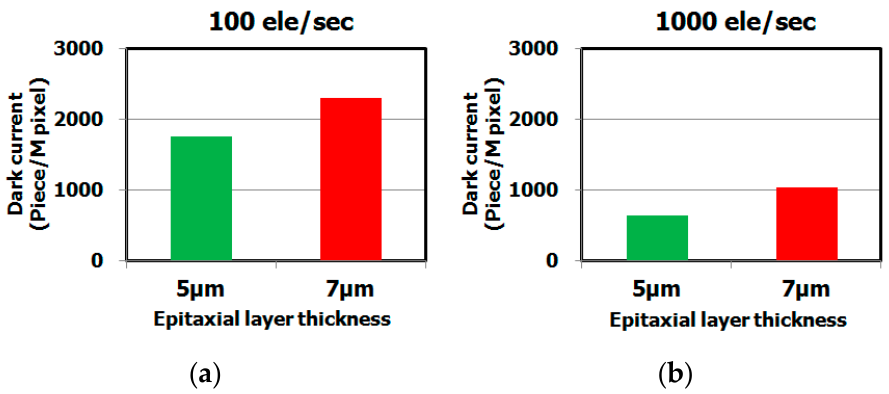
Figure 13. Histograms of dark current level of CMOS image sensor depending on epitaxial layer thickness. The dark current levels were measured by dark current spectroscopy under 60 °C. The hydrocarbon–molecular–ion dose amount is 1 × 10 15 cm − 2 . ( a ) Number of middle range in white spot level depends on epitaxial layer thickness, ( b ) Number of large range in white spot level depends on epitaxial layer thickness.